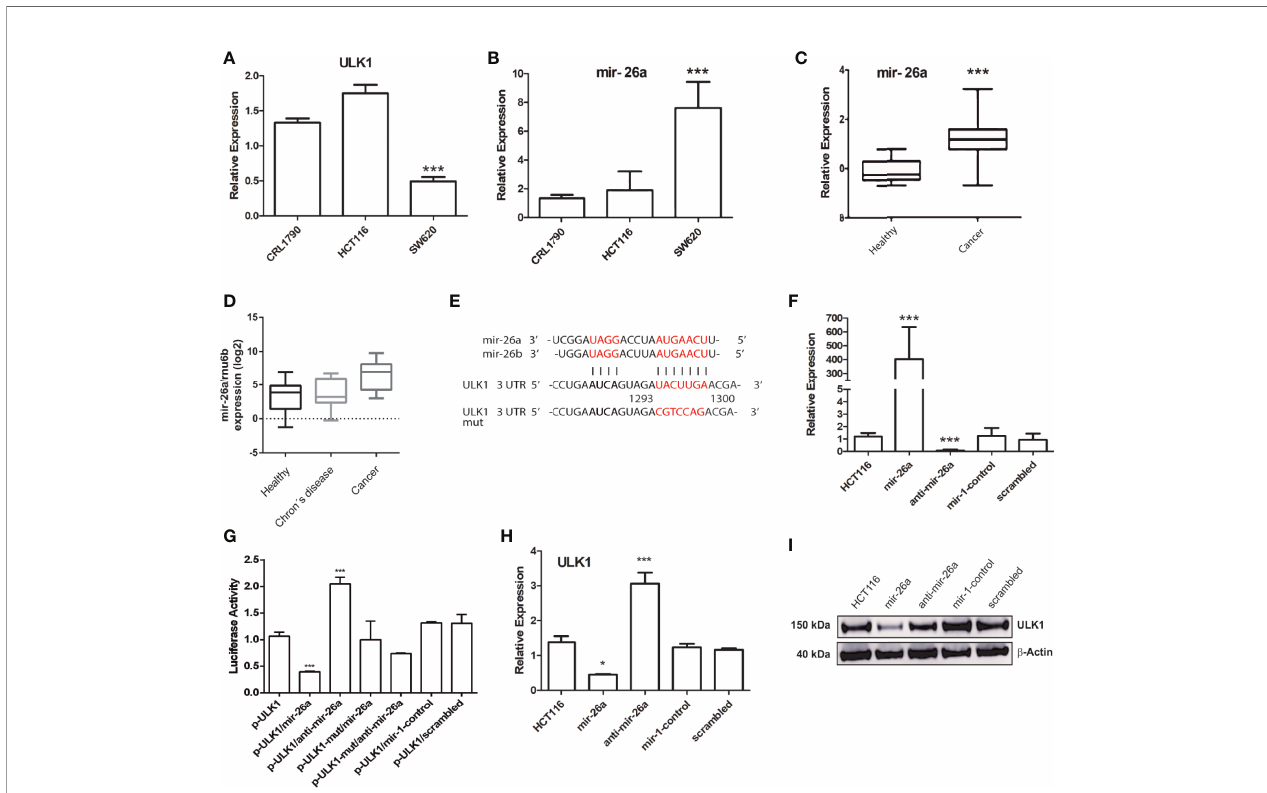
FIGURE 3 | Mir-26a regulates ULK1 expression in CRC cells. (A, B) Expression of ULK1 and mir-26a in CRL1790 (control cells), HCT116 and SW620 (CRC cell lines) normalized with GAPDH or RNU6, respectively. (C) mir-26a expression of colorectal cancer samples data obtained from “ The Cancer Genome Atlas ” (*p < 0.05). (D) mir-26a expression in CRC-derived paraf fi n-embedded, Crohn´s disease samples and non-tumoral samples was used as a control. (E) Binding site between ULK1 and mir-26a predicted by bioinformatic analysis. (F) Expression levels of mir-26a by transfection of mir-26a mimic or inhibitor in HCT116 cells.